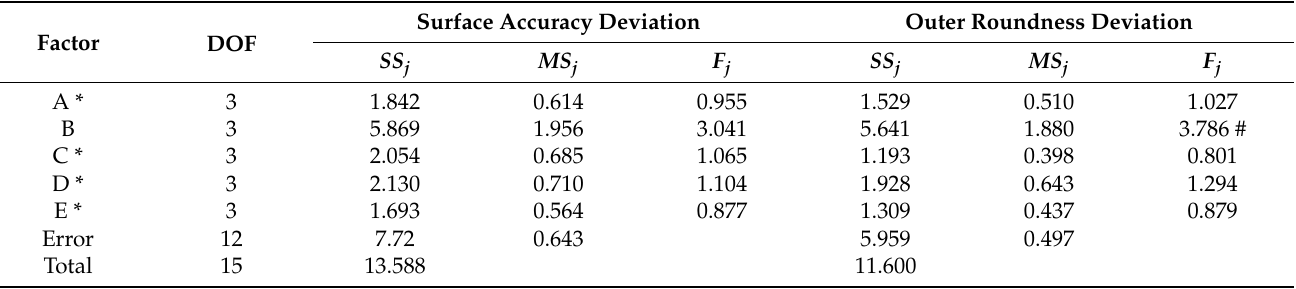
Table 7. The calculation method of deviation sum of squares, mean square deviation and F value was the following [30]. Table 7. ANOVA